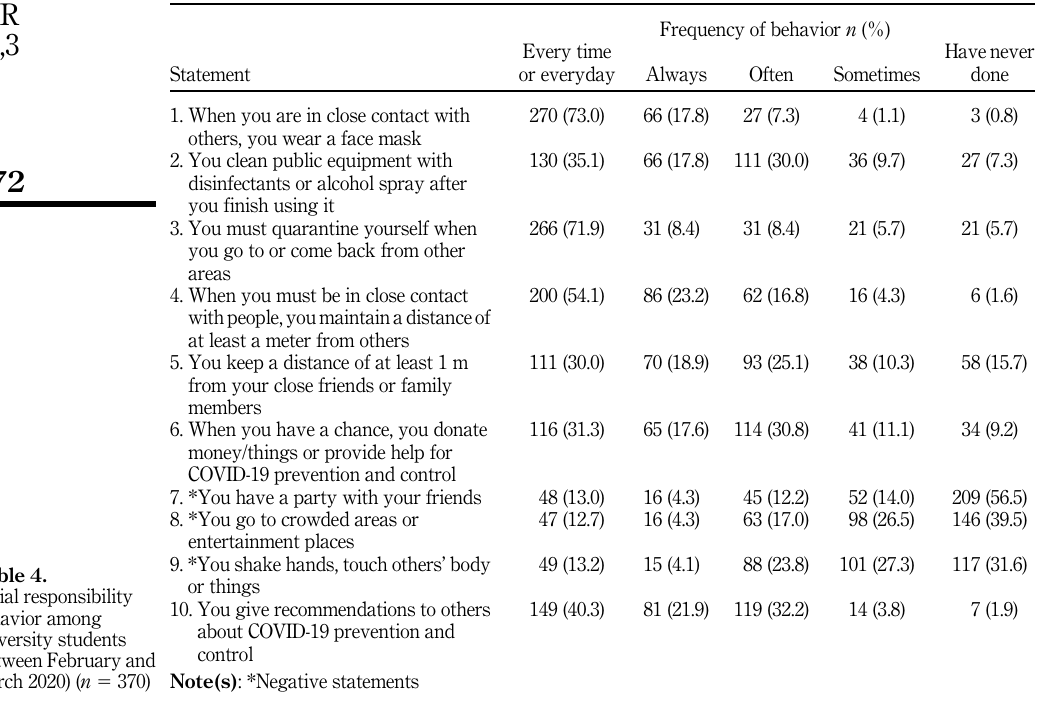
Table 5. Knowledge level of COVID-19 transmission, attitude level of the state measures and social responsibility